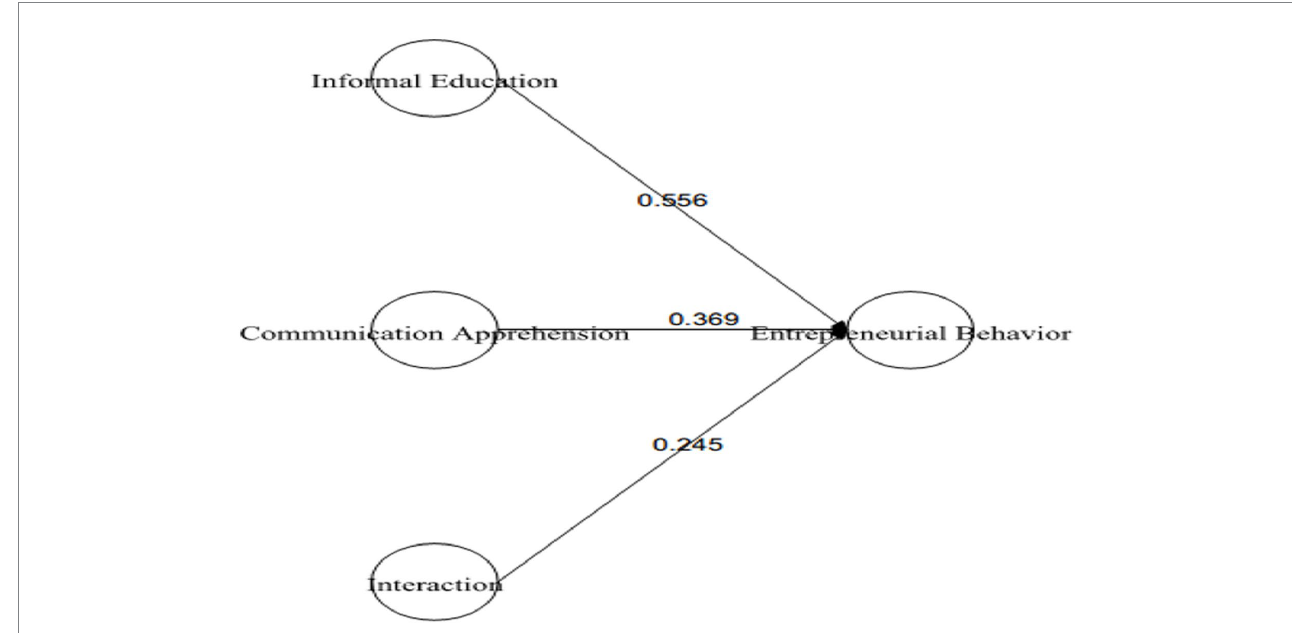
FIGURE 7 Moderating effect of TESOL amplified communication apprehension on the relationship of informal education—entrepreneurial behavior.